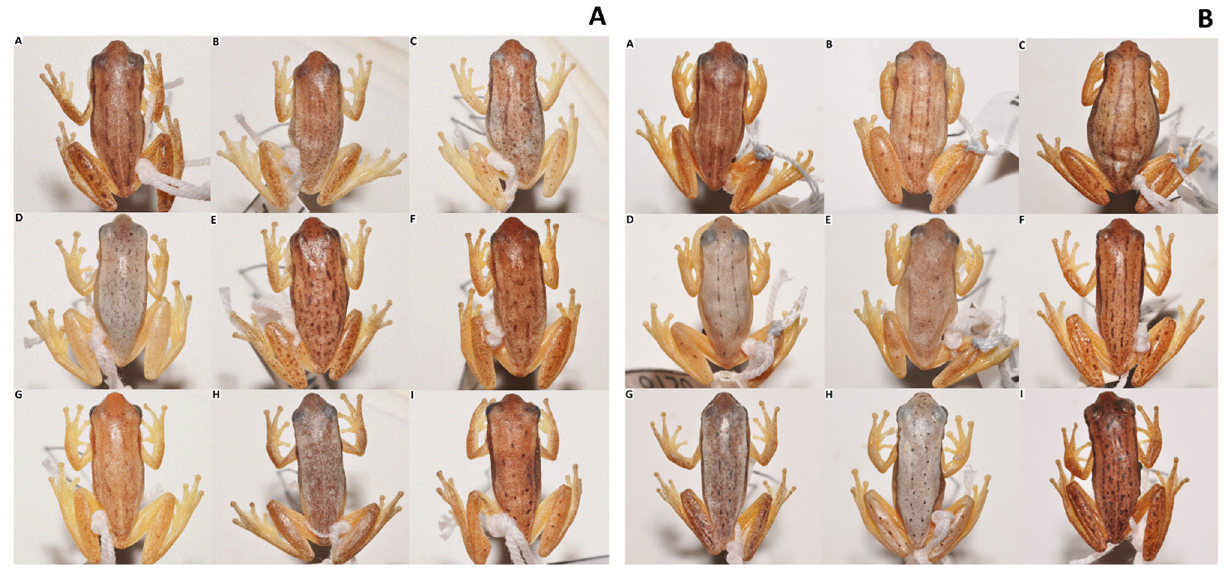
Figure 5. Preserved specimens assigned to Lineages B and E. Note the variation in color pattern and distribution of spots on the dorsum. ( A ) ( A – E ): Specimens UNEC 12433–37 collected from the type locality of D. nanus (Colonia Resistencia, Chaco, Argentina). ( F – I ): Specimens AAG-UFU 921–24 collected from Brejinho de Nazaré, Brazil. ( B ) ( A , B ): Specimens AAG-UFU 3252 and AAG-UFU 3254 from Belém, Pará, Brazil. ( C – I ): Specimens AAG-UFU 5306, AAG-UFU 5307, AAG-UFU 5309–11 and AAG-UFU 5342 from the type locality of D. walfordi (Forte Príncipe da Beira, Costa Marques, Rondônia, Brazil).